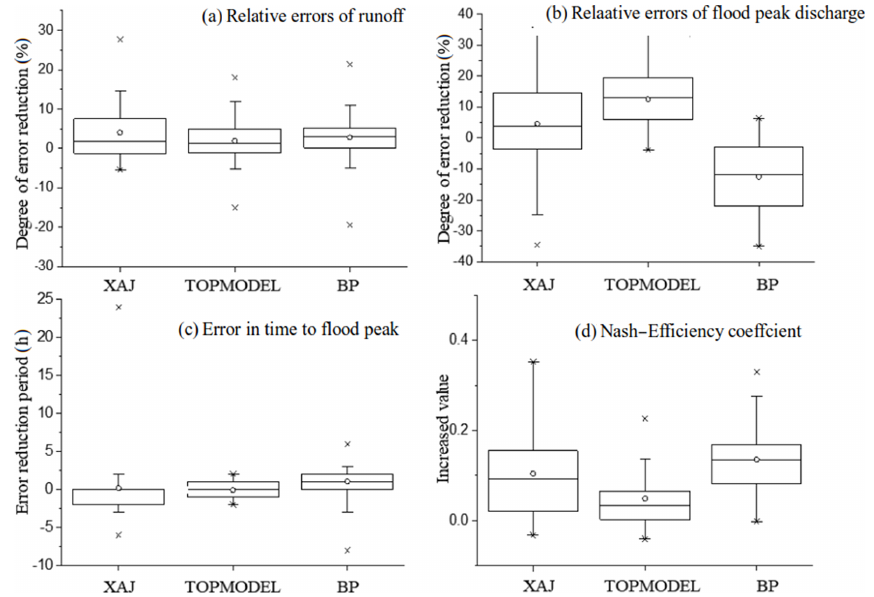
Figure 9. Multi-model ensemble changes relative to single model. Table 6. Multi-model ensemble